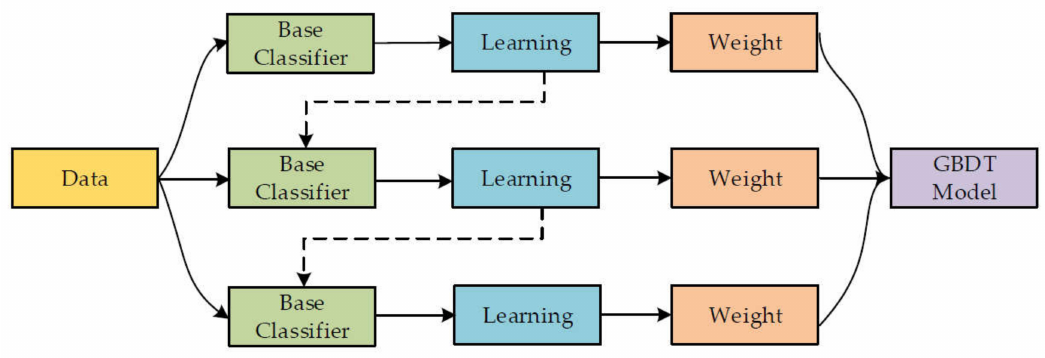
Figure 1. Gradient-boosting training process